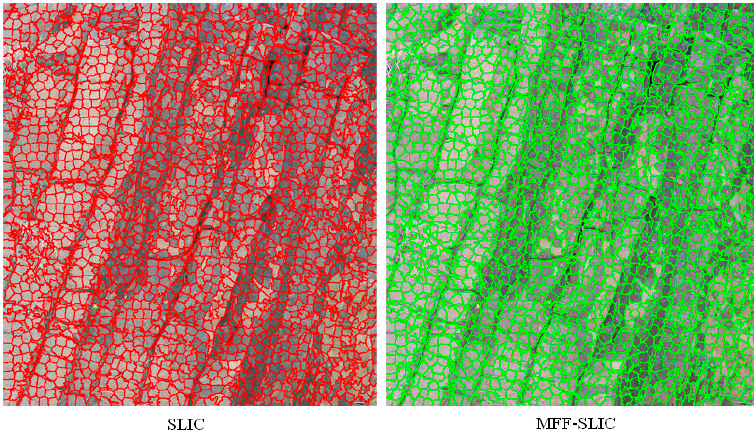
Figure 19. The comparison of segmentation results with 2500 superpixels.